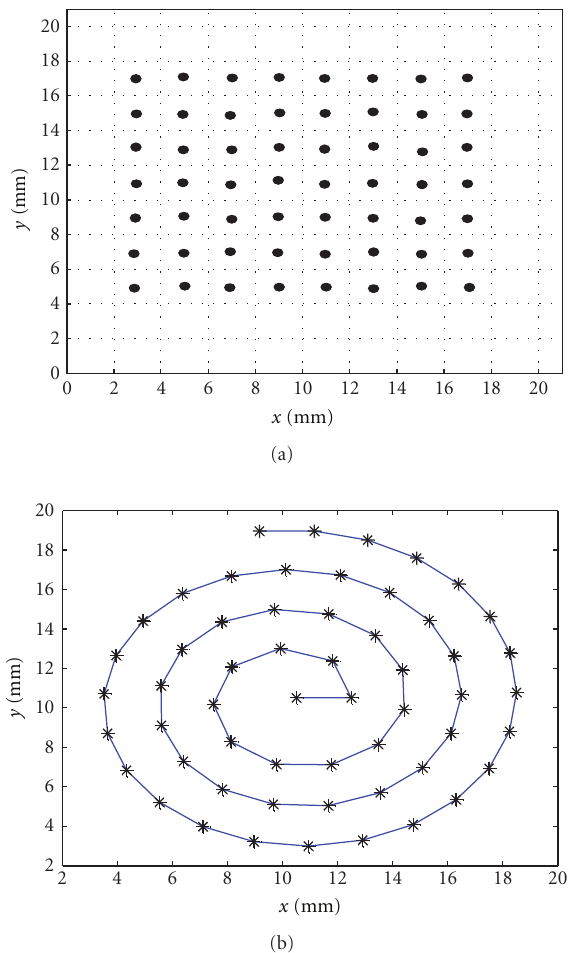
Figure 7: Points in the mid-plane of the computational domain through which the focus is stepped either in (a) a random way or sequential way, or (b) following a spiral trajectory.